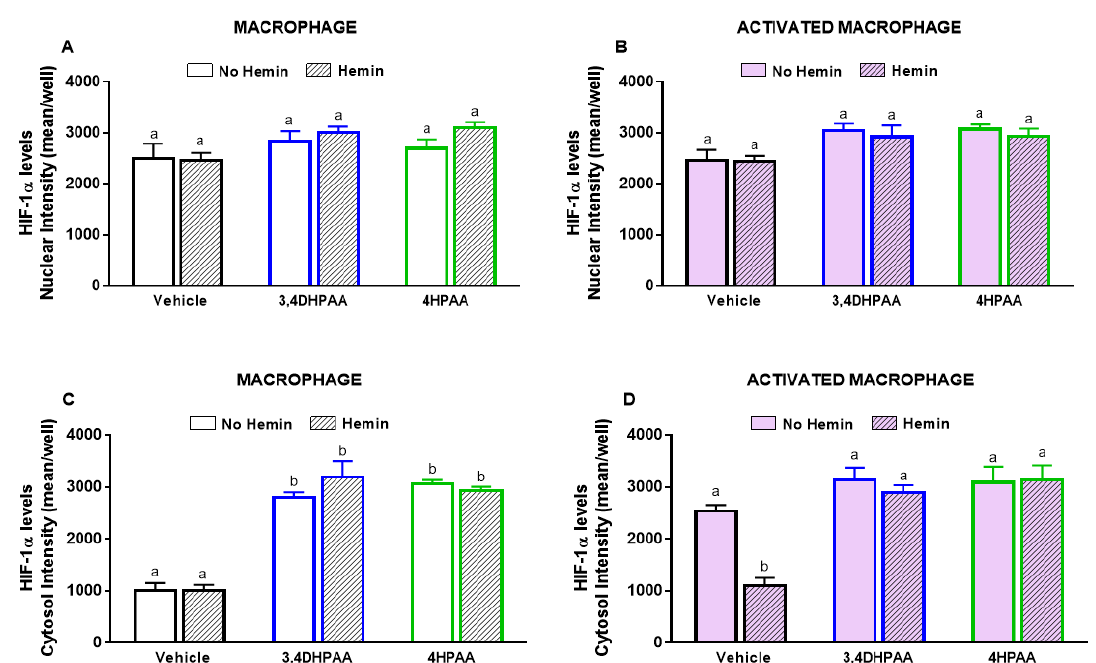
Figure 10. 3,4DHPAA and 4HPAA increase cytosolic HIF-1 α levels in macrophages and hemin reduces it in activated macrophages. Nuclear HIF-1 α levels in ( A ) macrophages and ( B ) activated macrophages; cytosolic HIF-1 α levels in macrophages ( C ) and ( D ) activated macrophages. HIF-1 α levels were measured in macrophages incubated with 10 µ M 3,4DHPAA or 10 µ M 4HPAA, in the presence or absence of 10 µ M hemin for 72 h. HIF-1 α levels were detected by immunofluorescence using a confocal imaging system (Opera Phenix, Perkin Elmer) and quantified using Harmony software (Perkin Elmer). Values with di ff erent superscript letters (a and b) indicate significant di ff erences ( p < 0.05) between groups. For all bars with the same letter, the di ff erence between the means is not statistically significant. 3,4DHPAA, 3,4-dihydroxyphenylacetic acid; 4HPAA, 4-hydroxyphenylacetic acid; HIF-1 α , hypoxia-inducible factor-1 alpha.